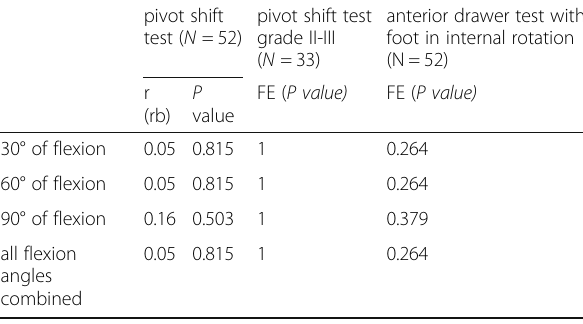
Table 5 Correlation between the TIR test and other diagnostic